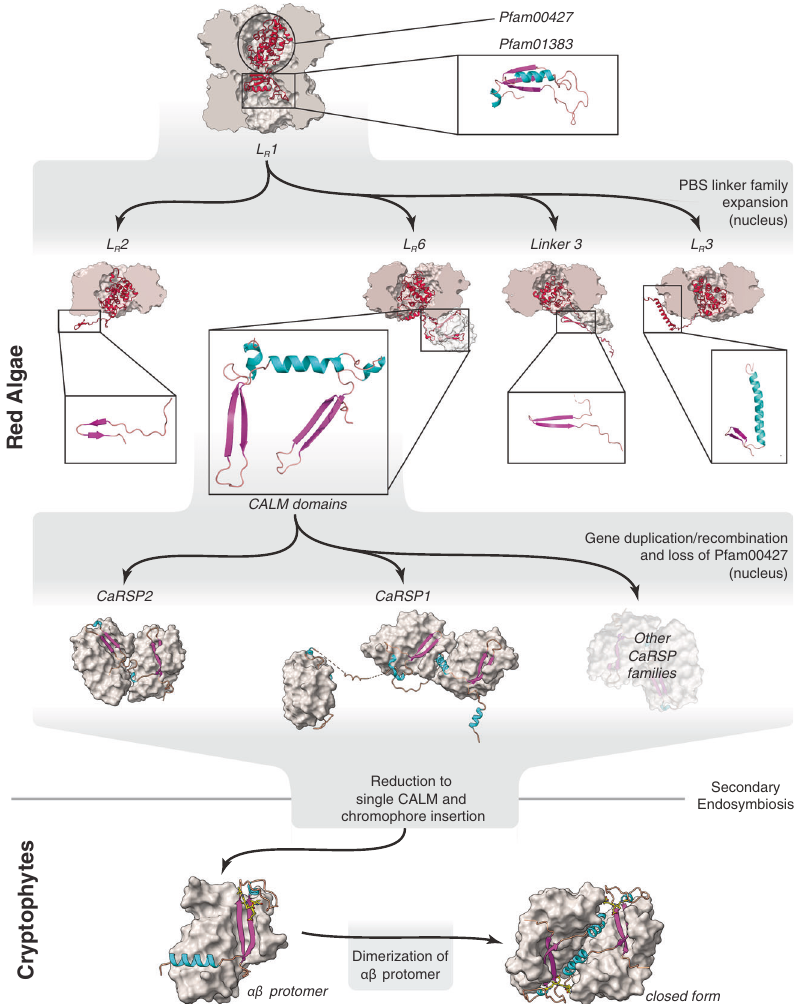
Fig. 4 Model for the evolution of red algal and cryptophyte antennas. Top row: Red algae acquire linker protein L R 1, which couples red algal PBS ring structures using its Pfam00427 and Pfam01383 domains (inset). Second row: the gene expressing L R 1 was transferred to the nucleus, where it expanded and diversi fi ed. L R 2, “ Linker 3 ” , L R 3 and L R 6 retain C-terminal domains with some similarity to Pfam01383. CALM domains appeared in the red algal PBS linker family (L R 6) or, alternatively, in an ancestral CaRSP. Third row: CaRSP proteins lose Pfam00427 domain, expand and diversify in the red algal nucleus. Bottom row: a single CALM protein appeared in the ancestral cryptophyte. It acquired a chromophore plus a plastid targeting sequence. It formed a stable cryptophyte- αβ protomer with a PE β subunit which then dimerised, creating the cryptophyte